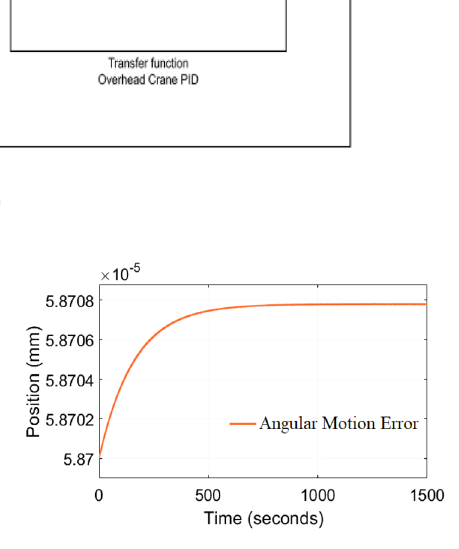
Fig. 10 The Error obtained from PID controller for swinging motion of the overhead